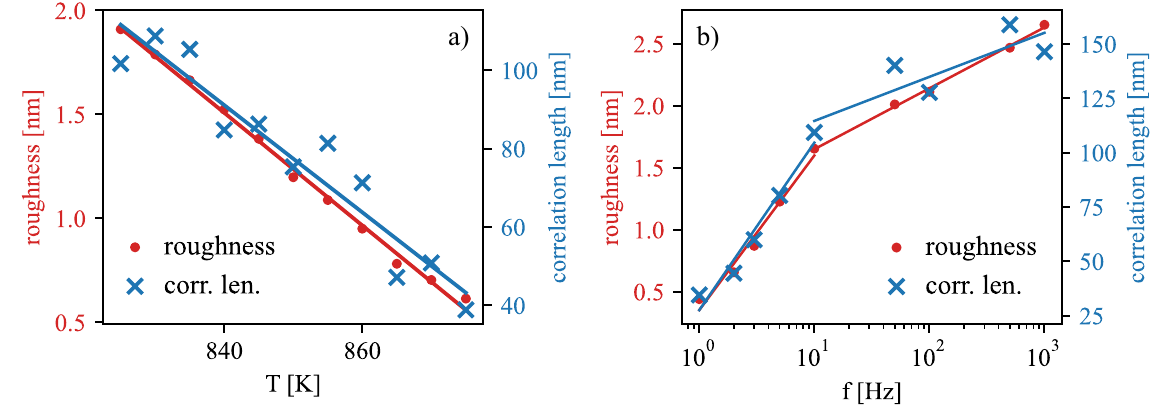
Figure 6. Dependency of simulated roughness and correlation length on temperature ( a ) and deposition frequency ( b ). The lines are guides for the eye.